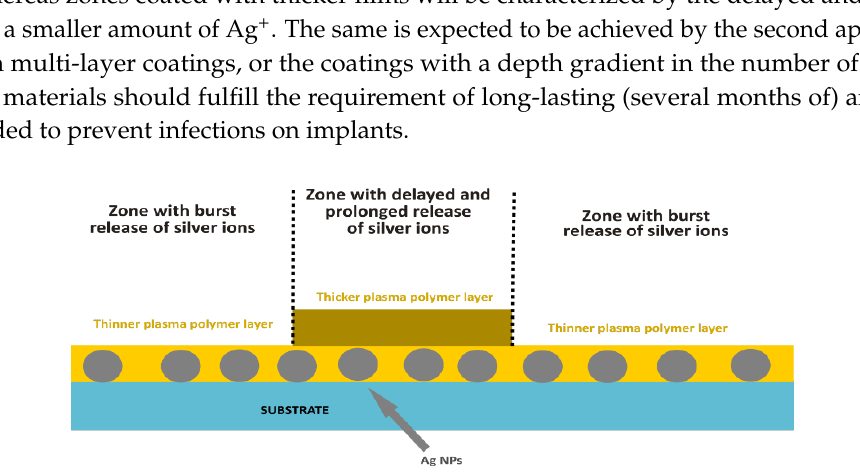
Figure 6. Ag-based multi-functional coatings with ( a ) non-fouling character, ( b ) Ag/plasma polymer